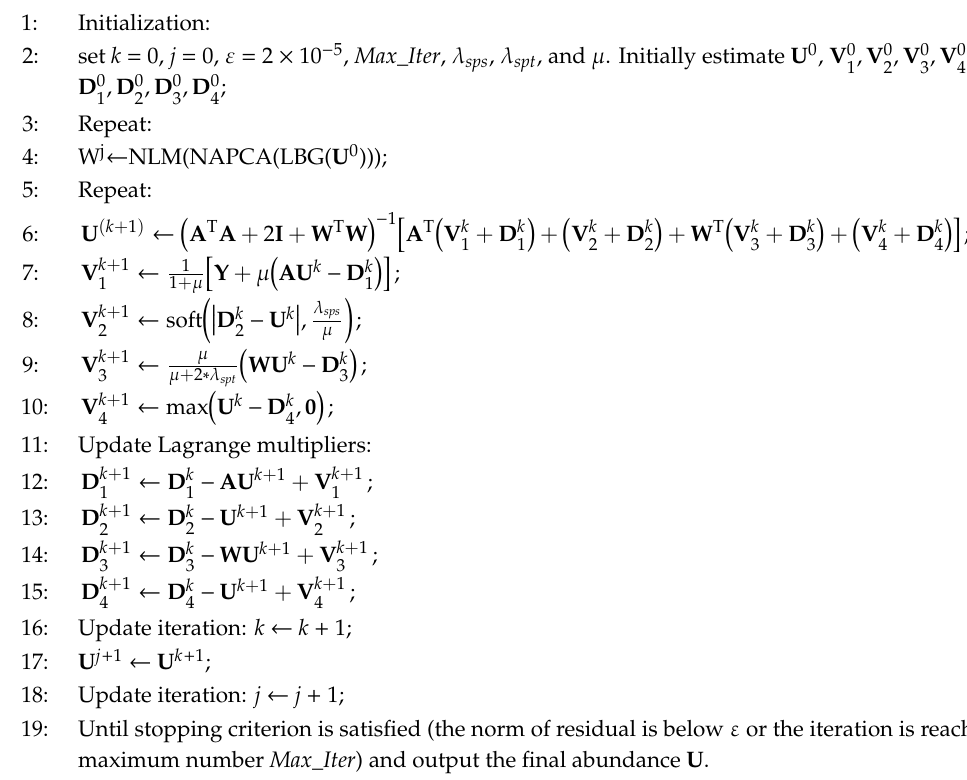
Algorithm 1: Pseudocode of the proposed